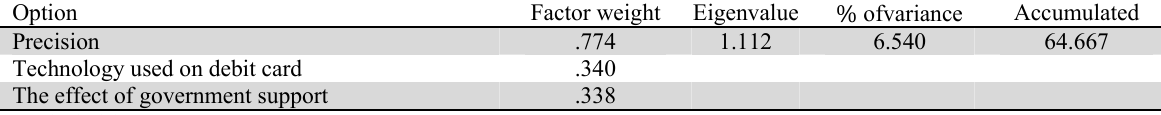
The summary of factors associated with Feasibility Option Factor weight Eigenvalue % ofvariance Accumulated Precision